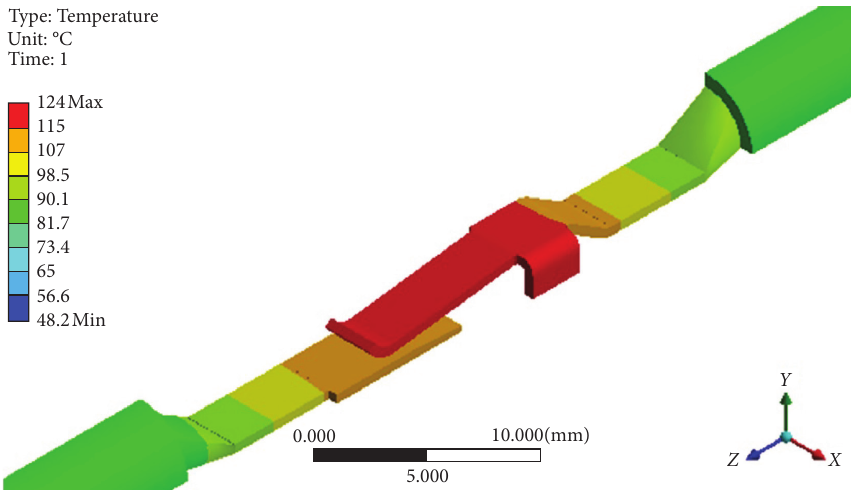
Figure 9: Temperature contour without R